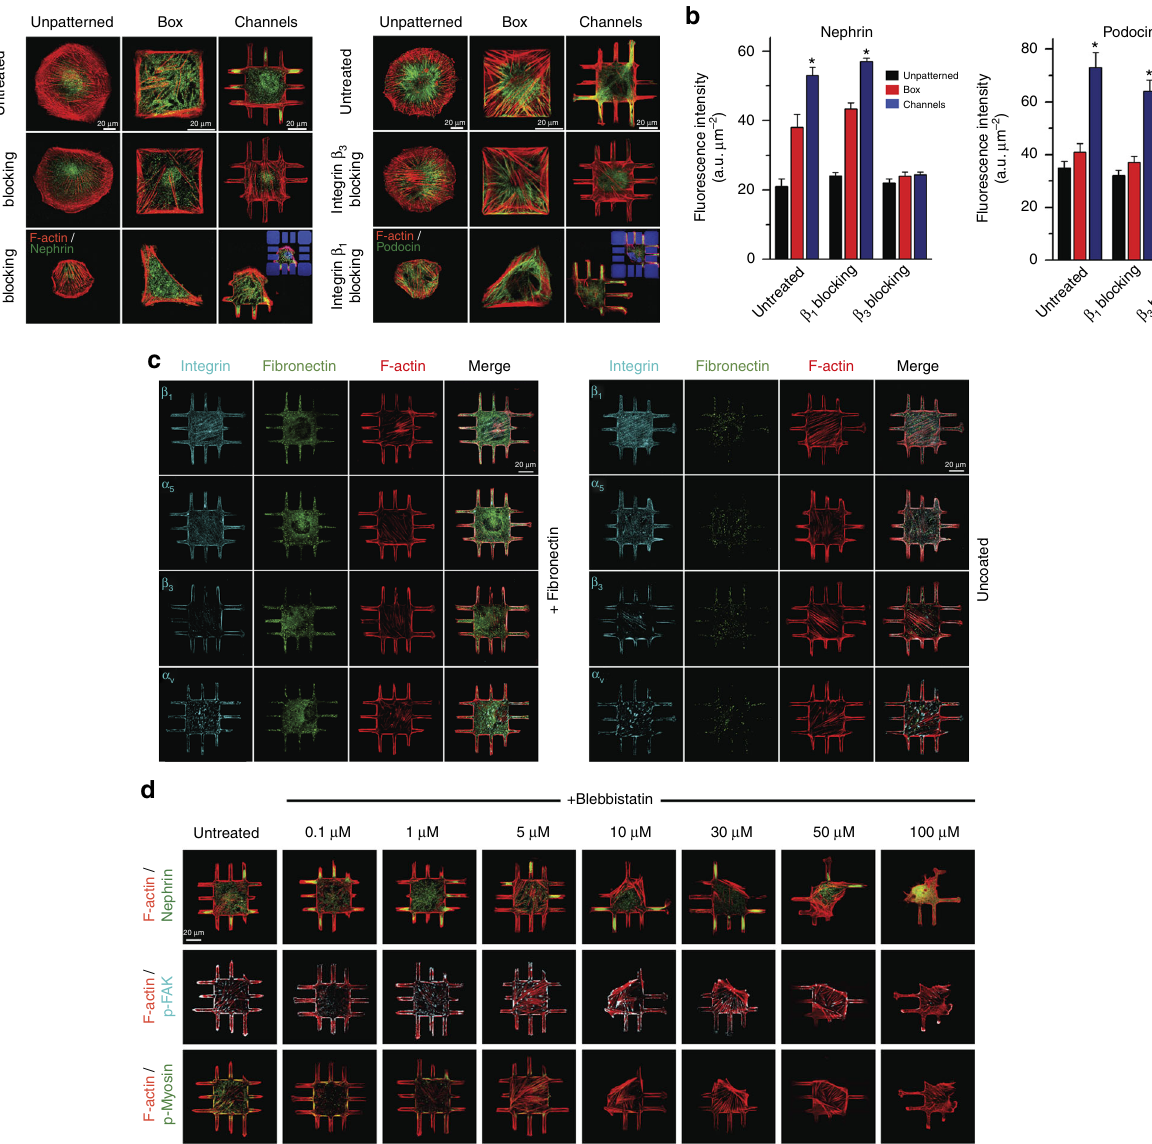
Fig. 3 Integrin β 3 controls shape-driven phenotype in podocytes. a Representative images of podocytes plated on unpatterned and micropatterned surfaces, and stained either for (left) nephrin (green) and F-actin (red), or (right) podocin (green) and F-actin (red). Both podocin and nephrin were highly localized within peripheral processes. Treating cells with integrin β 3 blocking antibodies abolished the localization effect. Podocytes treated with integrin β 1 blocking antibodies exhibit limited spreading; however, podocin and nephrin phenotype was relatively unaffected (insets show the auto fl uorescent patterns for clarity). b Quantitative analysis of whole-cell nephrin and podocin intensities in patterned and unpatterned podocytes treated with either β 1 or β 3 blocking antibodies. Values given as mean ± SEM; n = 80 chosen randomly from eight different slides cultured independently (* p < 0.01 vs. UNP; one-way ANOVA followed by a post hoc Tukey test). c No signi fi cant differences in integrin expression were observed between fi bronectin coated and uncoated surfaces; spatial integrin expression did not depend on the ECM coating in 3-D micropatterned podocytes. Integrin β 1 , α 5 , β 3 , and α v (cyan, stained independently), fi bronectin (green), and F-actin (red) in podocytes plated on channel surfaces with and without fi bronectin coating. d Podocytes were treated with varying concentrations of blebbistatin for 12 h prior to fi xation and stained for (top) nephrin (green) and F-actin (red), (middle) p-FAK (cyan) and F-actin (red), or (bottom) p-myosin (green) and F-actin (red). Phospho-myosin intensity decreased gradually with increasing blebbistatin concentration, whereas recruitment of p-FAK to focal adhesions was not affected by blebbistatin up to 10 μ M with an increasing aspect ratio that would increase intracellular cellular phenotypes can be regulated independently by shape and cytoskeletal tension. We evaluated vimentin localization in tension signals, and that a transition between states is determined fi broblasts, which was shown to be a critical modulator of spatial by the inherent sensitivity of the cell. To validate model predic- cell biomechanics, changing its cytosolic distribution in response tions, we performed time-series measurements of nephrin and to cellular tension 35 . Vimentin localization in fi broblasts (i.e., area vimentin localization in micropatterned podocytes and fi bro- normalized intensity within the tip vs. main body) was compared blasts. Podocytes were cultured on the 3-D channel micro- to nephrin localization in podocytes (i.e., branches vs. cell body). patterns, while fi broblasts whose function is dependent on Measurements were carried out in cells treated either with contractile tension 34 were cultured on rhombus micropatterns NATURE COMMUNICATIONS | 8: 2145 | DOI: 10.1038/s41467-017-02218-4 |